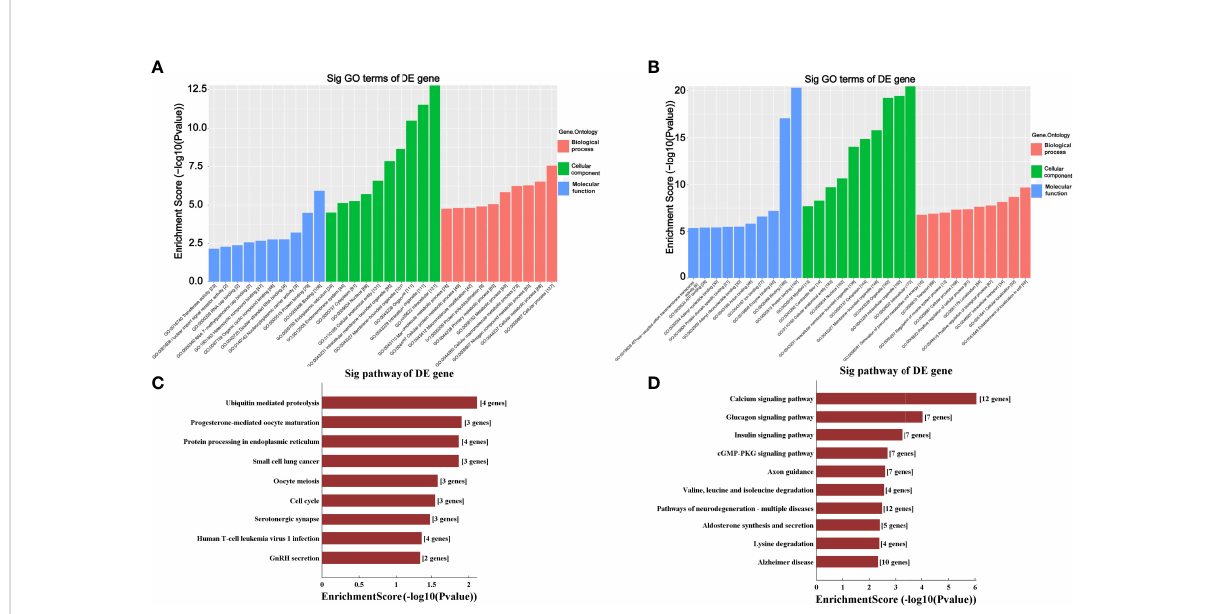
FIGURE 5 Gene Ontology (GO) and Kyoto Encyclopedia of Genes and Genomes (KEGG) analyses for upregulated and downregulated circRNAs. (A, B) GO analysis predicted the top 10 upregulated (A) and the top 10 downregulated (B) enriched genes in biological processes, cellular components or molecular functions based on their fold enrichment scores. (C, D) KEGG pathway analysis predicted the top 10 upregulated (C) and the top 10 downregulated (D) enriched pathways of DE-circRNAs parental genes. Sig, signi fi cantly; DE-circRNAs, differentially expressed circRNAs; DE- genes, differentially expressed